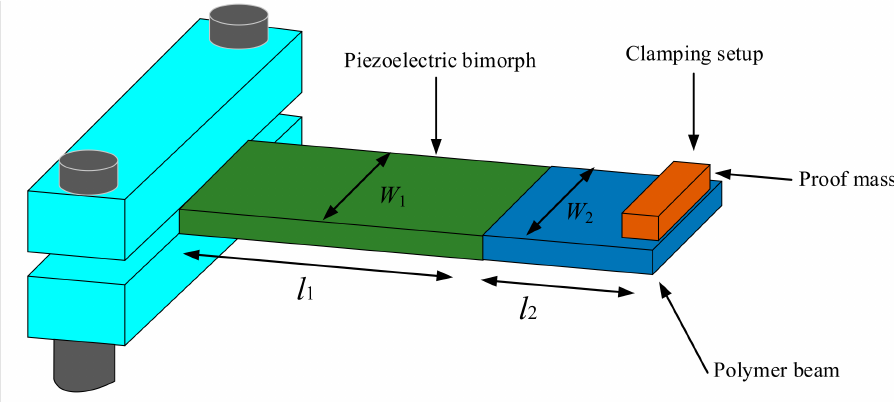
Figure 15. Design of PEH-S with a polymer spring attached to piezoelectric bimorph